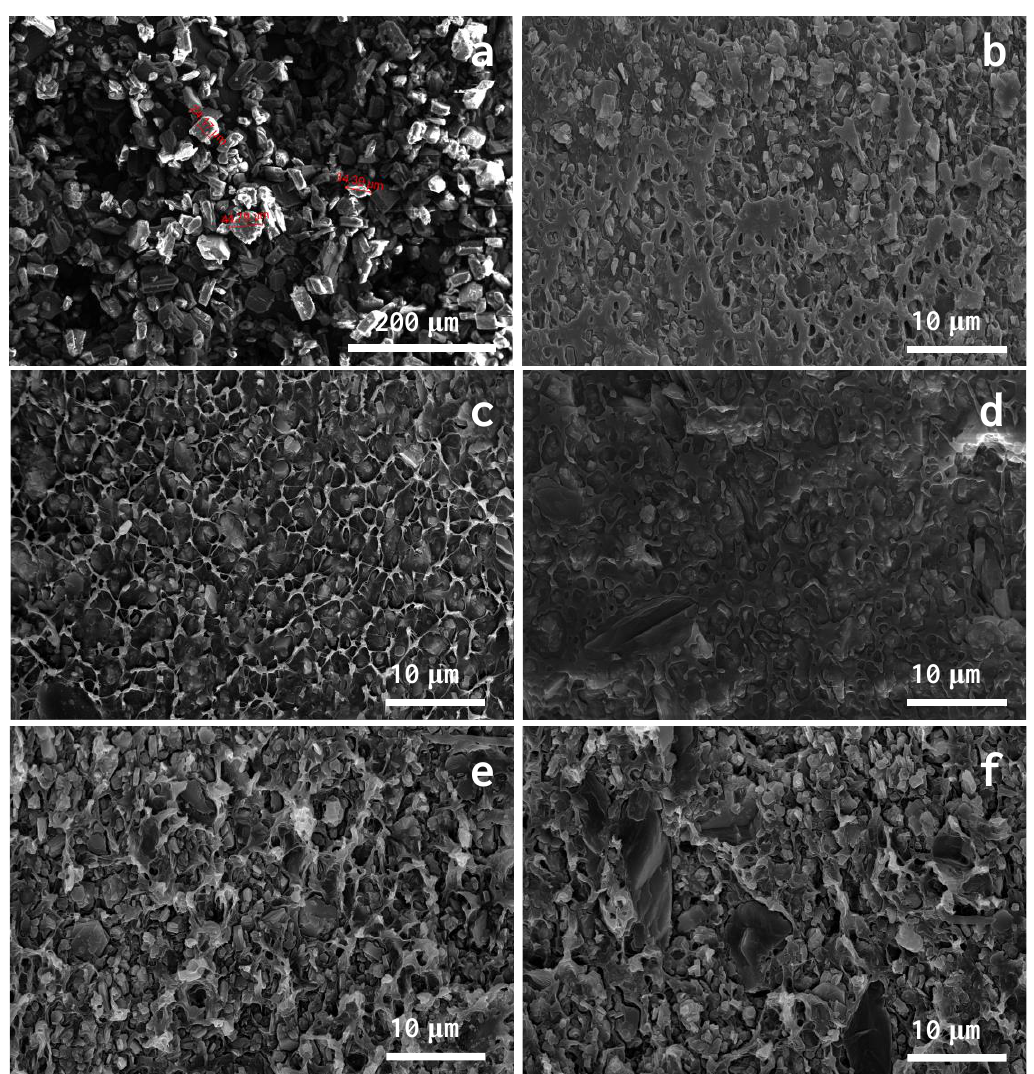
Figure 4. SEM images of CN‐CP powder and its composites (( a ) CN‐CP powder; ( b ) PE‐CN‐1; ( c ) PE‐CN‐2; ( d ) PE‐CN‐3; ( e ) PE‐CN‐4; ( f ) PE‐CN‐5).